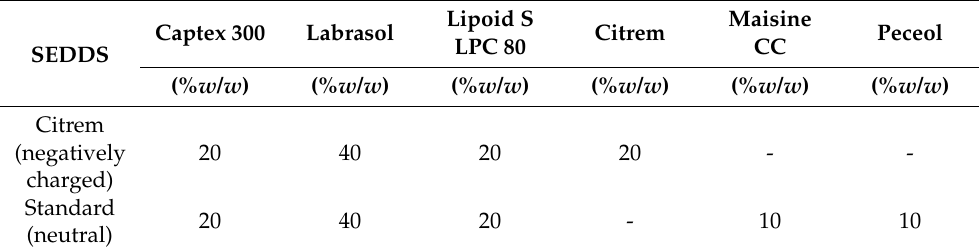
Table 1. Composition of the self-emulsifying drug delivery systems